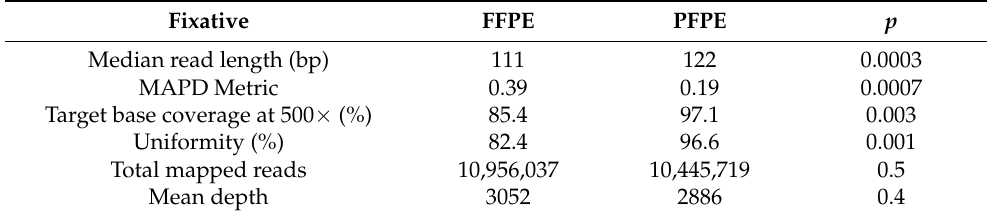
Table 3. Targeted next-generation sequencing quality metrics in Formalin-fixed and PAXgene-fixed tissue